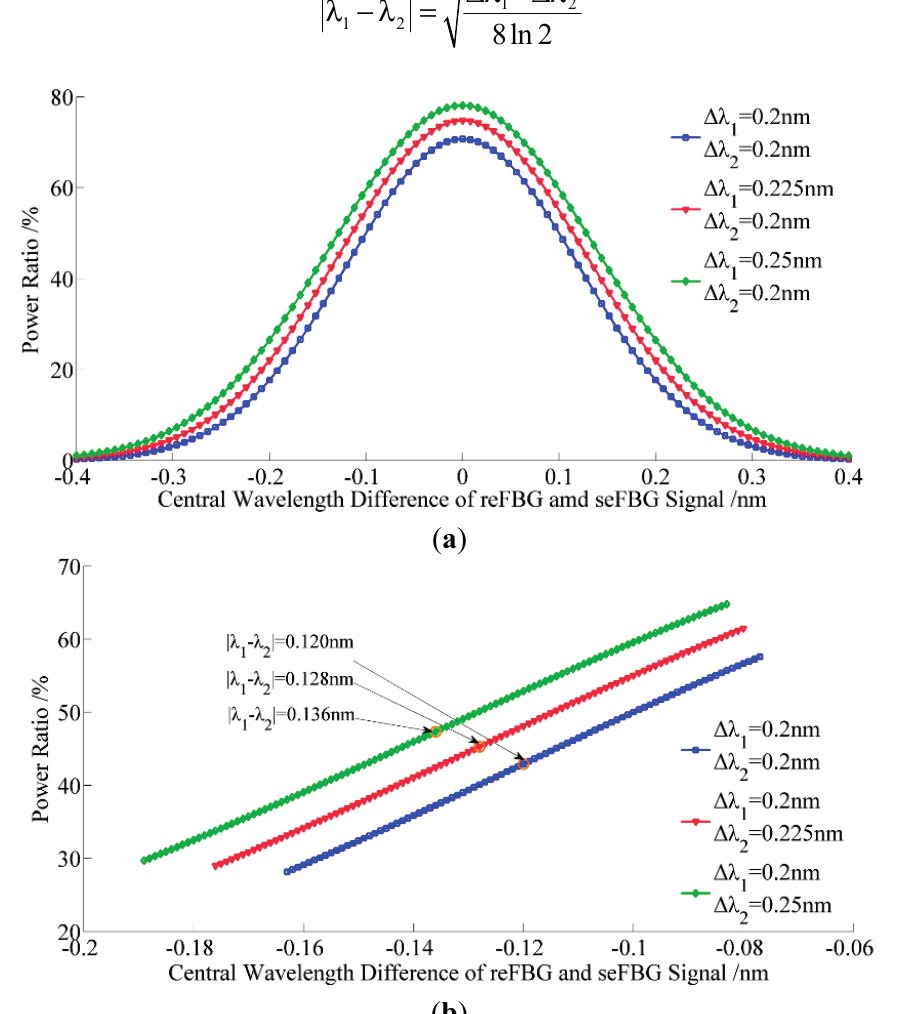
Figure 6. Relation between the power ratio and the central wavelength difference between the reFBG and seFBG while the FWHM of the seFBG and reFBG are not equal: ( a ) full scale ( b ) most sensitive section with the nonlinearity of